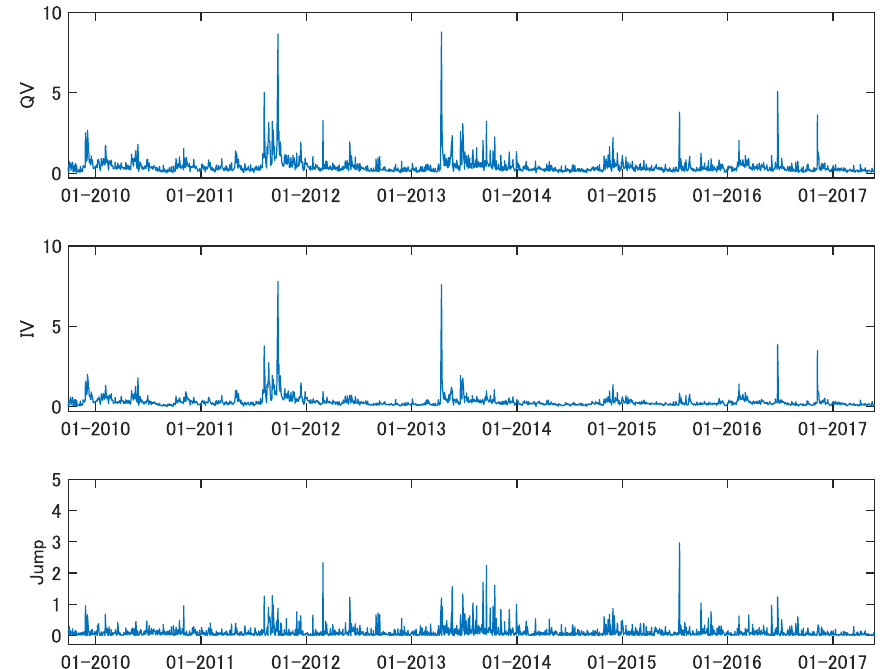
Figure 1. Estimates of Quadratic Variation, Integrated Volatility, and Jump Variability for Crude Oil